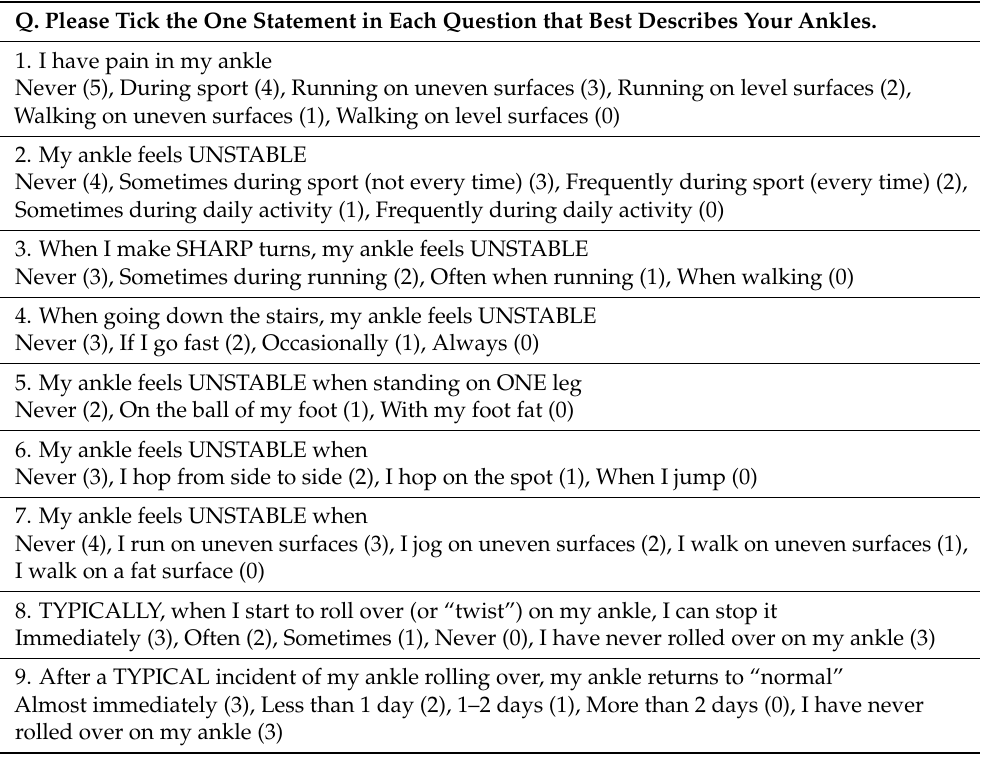
Table 1. Nine items and scores of the Cumberland Ankle Instability